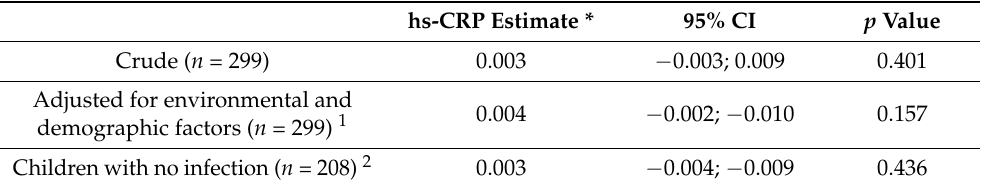
Table 2. The association between log hs-CRP and vitamin D at age 6 months in COPSAC 2000 from uni- and multivariable linear regression